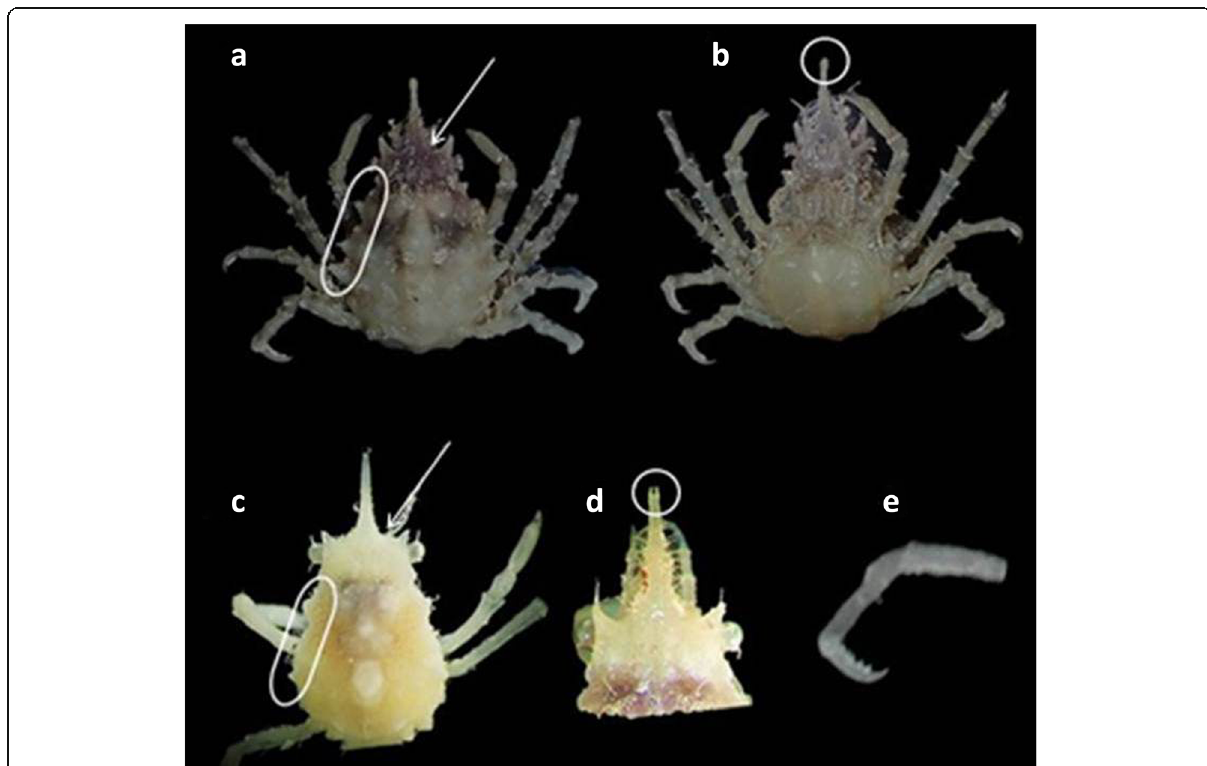
Fig. 1 Two morphotypes of M . monoceros , 27° 17 ′ 18.9 ″ N, 33° 45 ′ 46.6 ″ E, Hurghada, Red Sea, Egypt. RCAZUE-Crus-Br.26151.13 ( a , b Cl=13.4mm; c – e Cl= 6.9mm)